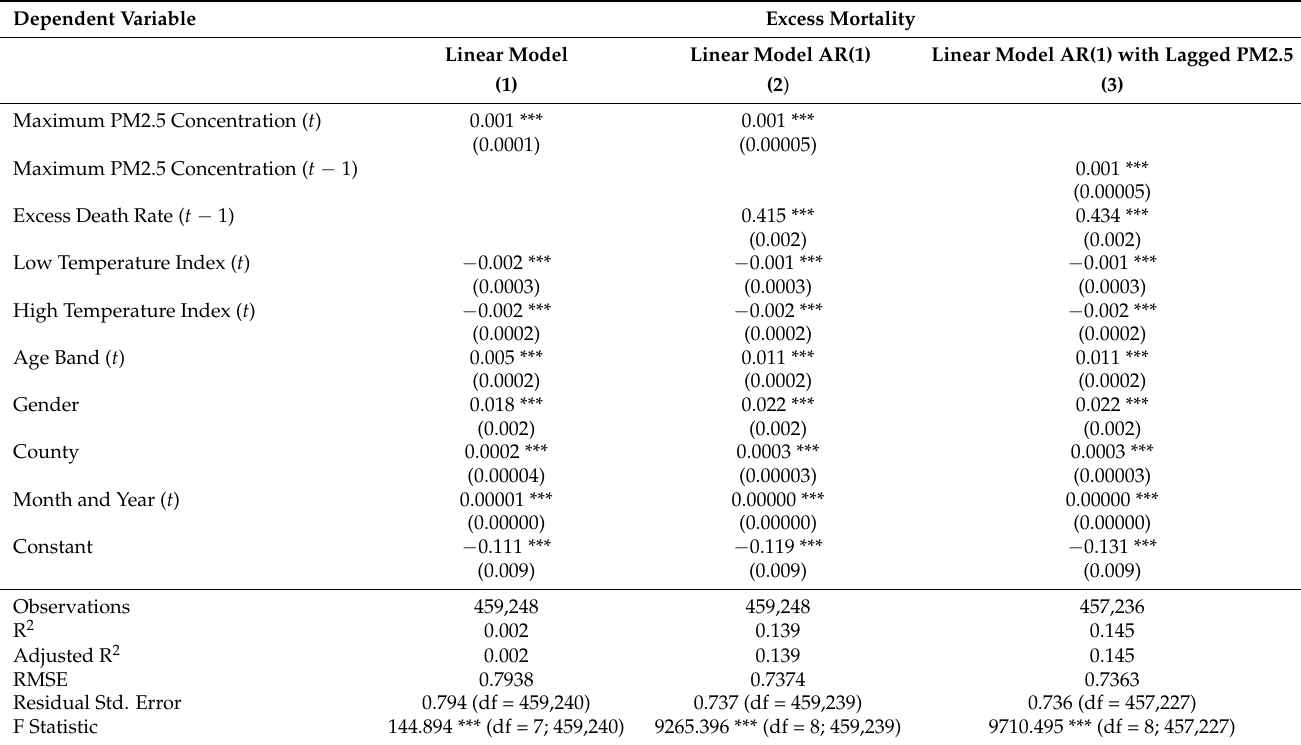
Table 1. Linear Regression Model Results for Excess